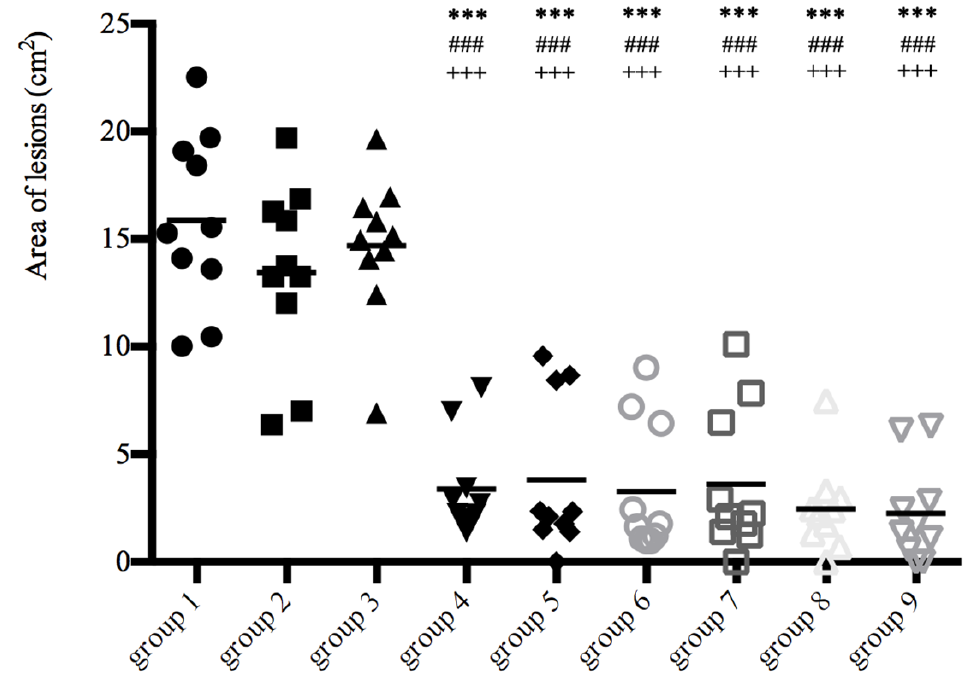
Figure 3. Lesion areas of the rabbit hind limbs at four weeks post-mite challenge. Group 1, vaccinated with 1 mL 0.01 M PBS each time; group 2, vaccinated with 1 mL QuilA saponin at a concentration of 1 mg / mL (dissolved in PBS) each time; group 3, vaccinated with 100 µ g (first time) and 100 µ g (second time) purified pET-32a ( + )Trx-His-S tag protein with 1 mL QuilA saponin at a concentration of 1 mg / mL (dissolved in PBS); group 4, group 5, group 6, and group 7 refer to the test groups immunized with 100 µ g purified rSsCLP5 or rSsCLP12 protein with 1 mL Quil-A saponin at a concentration of 1 mg / mL (dissolved in PBS) for the first and second immunizations, respectively; group 8 and group 9 refer to the test groups immunized with the mixture of 100 µ g rSsCLP5 protein and 100 µ g rSsCLP12 with 1 mL Quil-A saponin at a concentration of 1 mg / mL (dissolved in PBS) for the two immunizations. The lesion areas in the rSsCLP immunized groups (rSsCLP5, rSsCLP12, and rSsCLP5 + rSsCLP12) were significantly lower than that in the PBS control (*** p < 0.01), Quil A control (### p < 0.01) and Trx-His-S tag protein control ( +++ p <